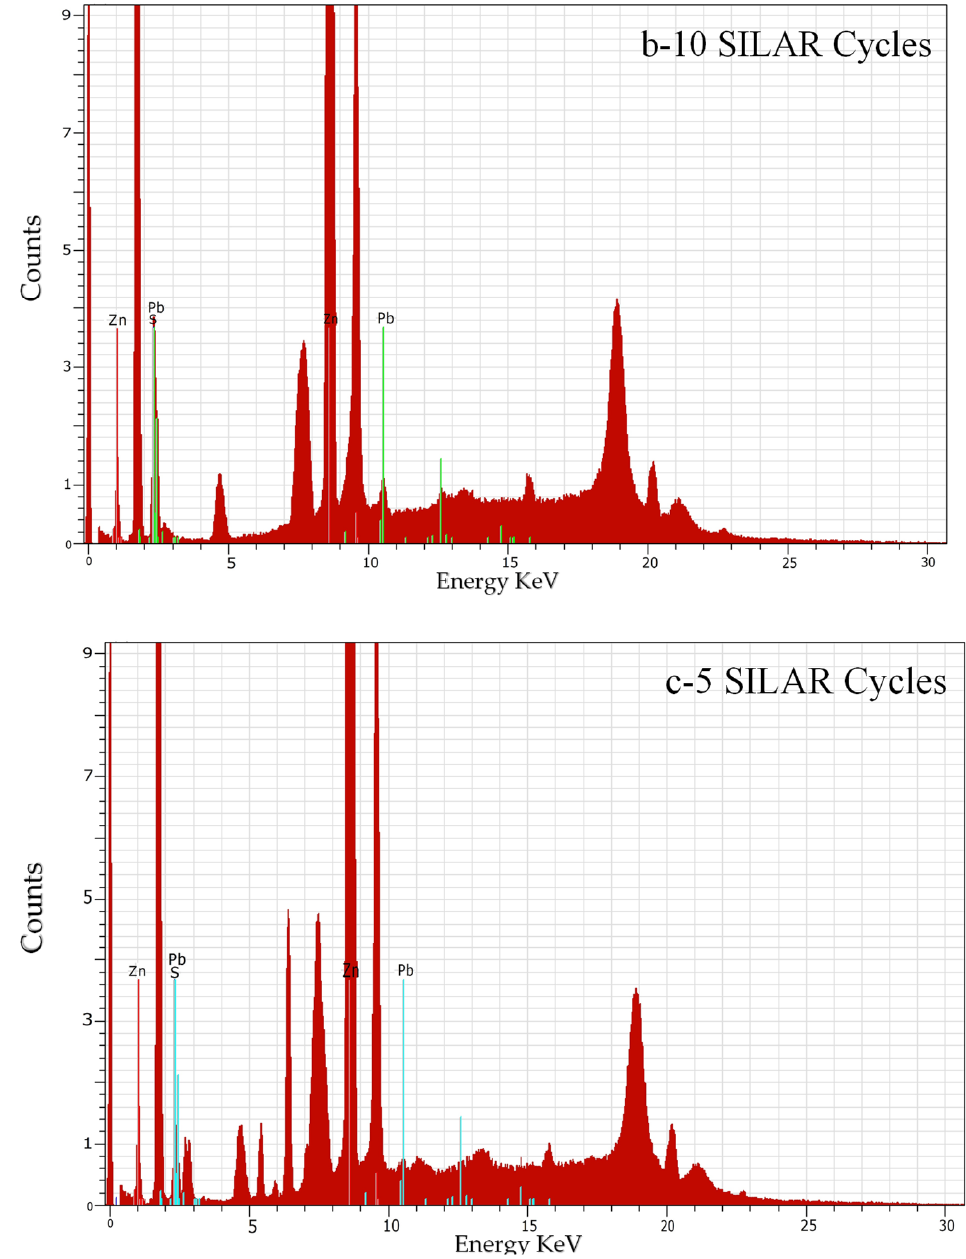
Figure 8. XRF spectra of the ZnO/PbS heterostructure at different concentrations.